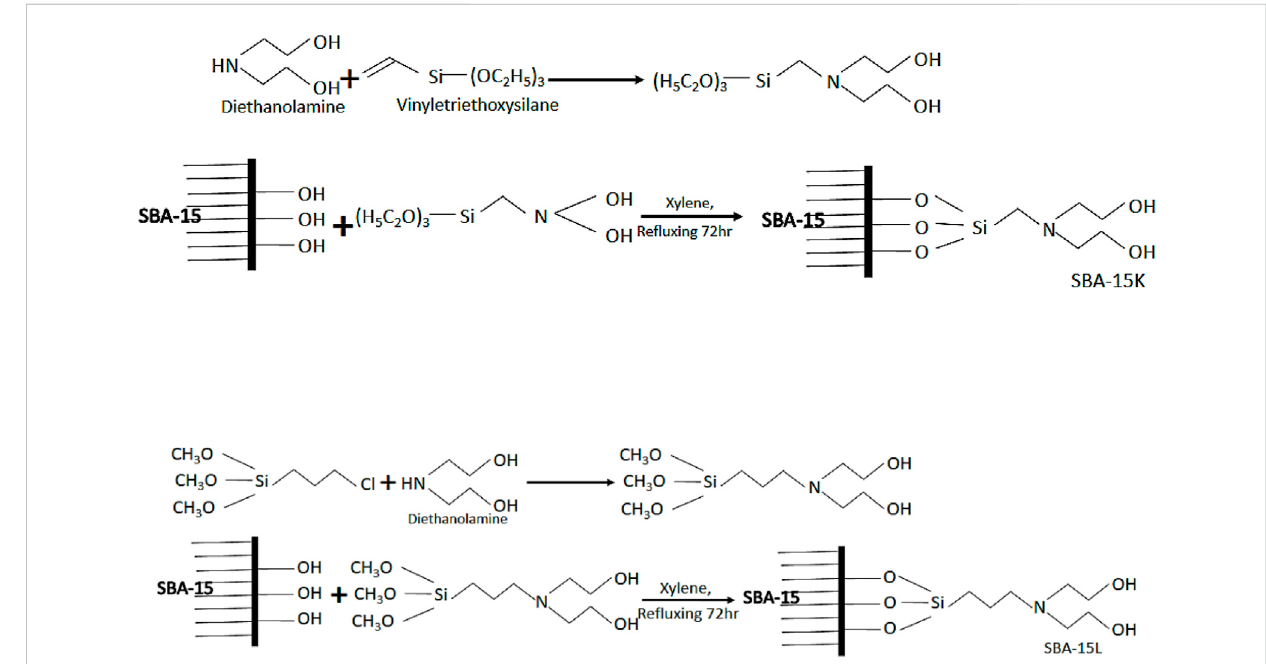
FIGURE 1 Schematic representation for the fabrication of silica SBA@N (Scheme 1) and SBA@3N (Scheme 2).